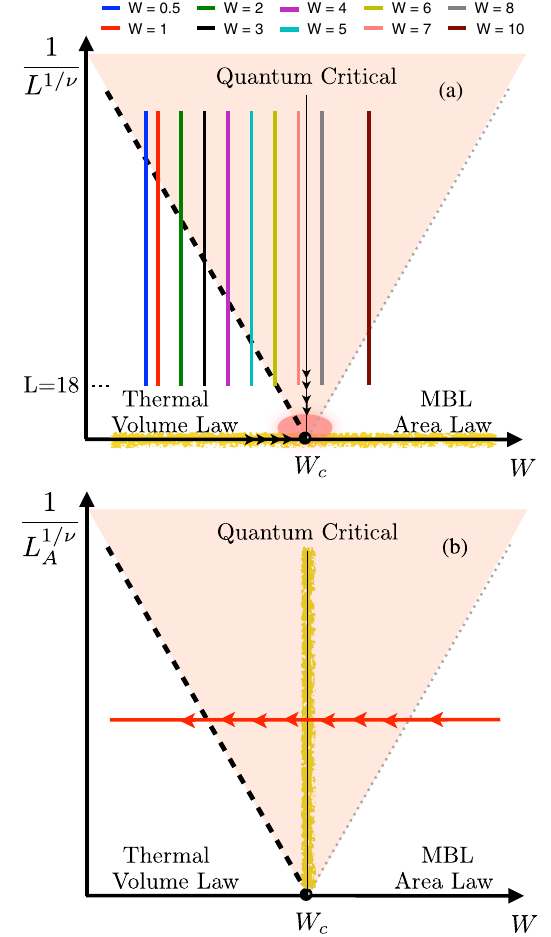
FIG. 4. The MBL-to-thermal phase transition and finite-size crossovers as a function of (a) L= ξ and (b) L A = ξ (schematic). For the single-site entropy S 1 , the only relevant scaling variable is L= ξ , and the curves at fixed W in Fig. 3 correspond to the vertical lines in the crossover phase diagram (a), with the subthermal plateaus lying in the QC regime. Grover ’ s analysis [26] considers L = ξ as the relevant scaling variable (b) and shows that if S A continuous across W c then it must be thermal in the critical regime. The inconsistency between pictures (a) and (b) can be reconciled if there is a discontinuity in S A at W c in the limit L → ∞ (yellow